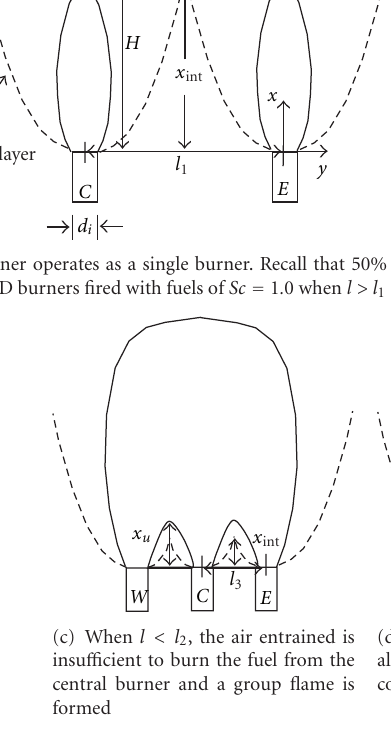
Figure 8: Qualitative illustration of the e ff ect of flame interaction: (a) isolated flames, (b) individual flames, (c) group flame, and (d) sheath flame.